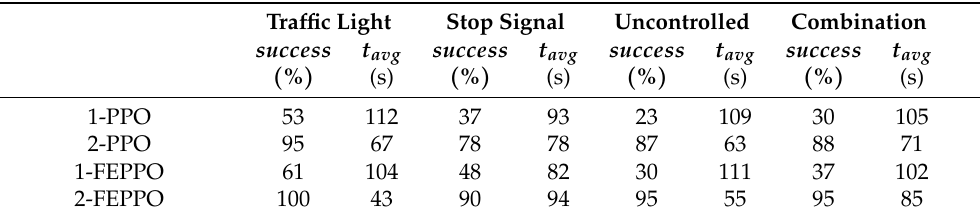
Table 2. Evaluation metrics results in SUMO simulator: comparison between algorithms trained with and without features structure.